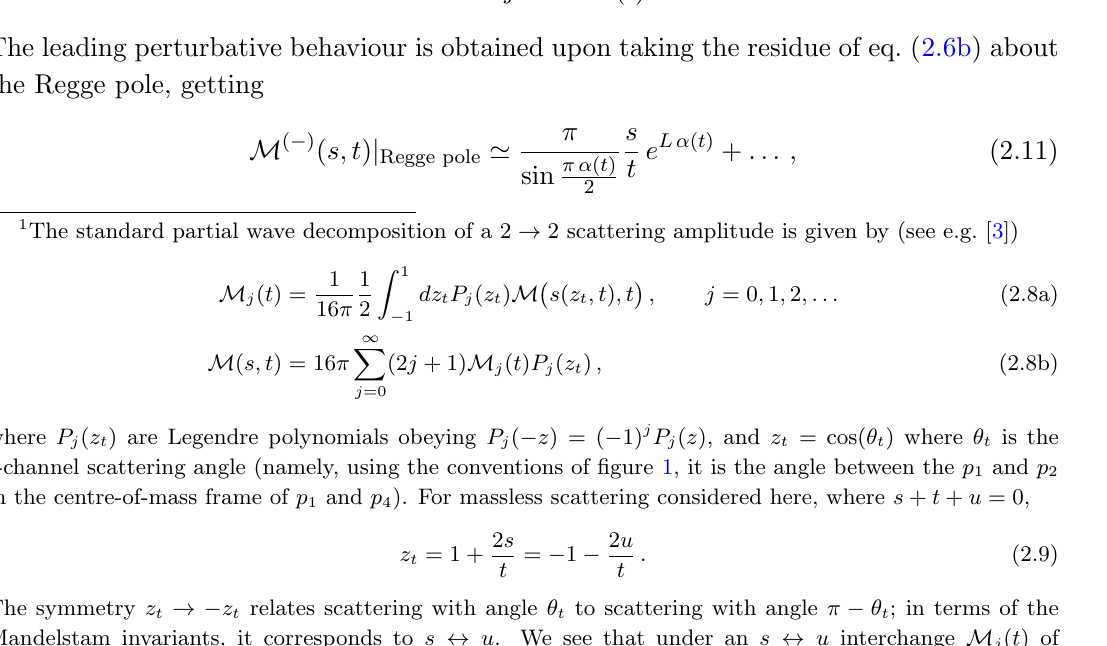
Figure 1 . The t -channel exchange dominating the high-energy limit, s de(cid:12)nes our conventions for momenta assignment and Mandelstam invariants. We shall assume that particles 2 and 3 are of the same type, and similarly for particles 1 and